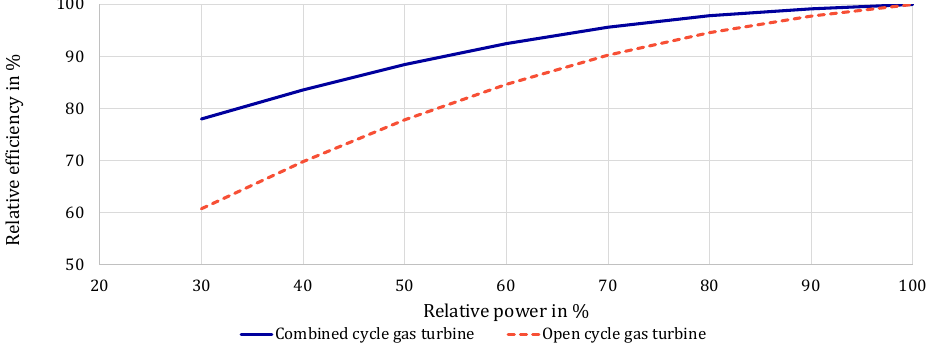
Figure 1. Relative efficiency curves for combined cycle gas turbines (solid line) and open cycle gas turbines (dashed line) according to [27].